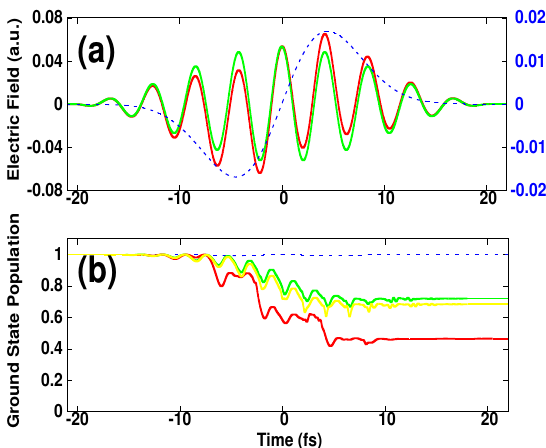
Figure 1. (Color online). ( a ) Laser pulses. ( b ) 1D—calculations of the temporal evolution of the population of the ground state induced by: the NIR pulse alone (green curve), the IR pulse alone (blue dashed line), and by the combined pulses (red curve). The corresponding pulses are shown in the top with the same colors. The parameters of the NIR pulse are: λ NIR = 1.27 µ m, T c = 10 cycles, δφ = 0 and I NIR = 1 × 10 14 W/cm 2 . The parameters of the IR pulse are: λ IR = 12.7 µ m and I IR = 1 × 10 13 W/cm 2 . It is also shown, for reference, the population induced by only the NIR pulse, but for a peak intensity of 1.1 × 10 14 W/cm 2 (yellow